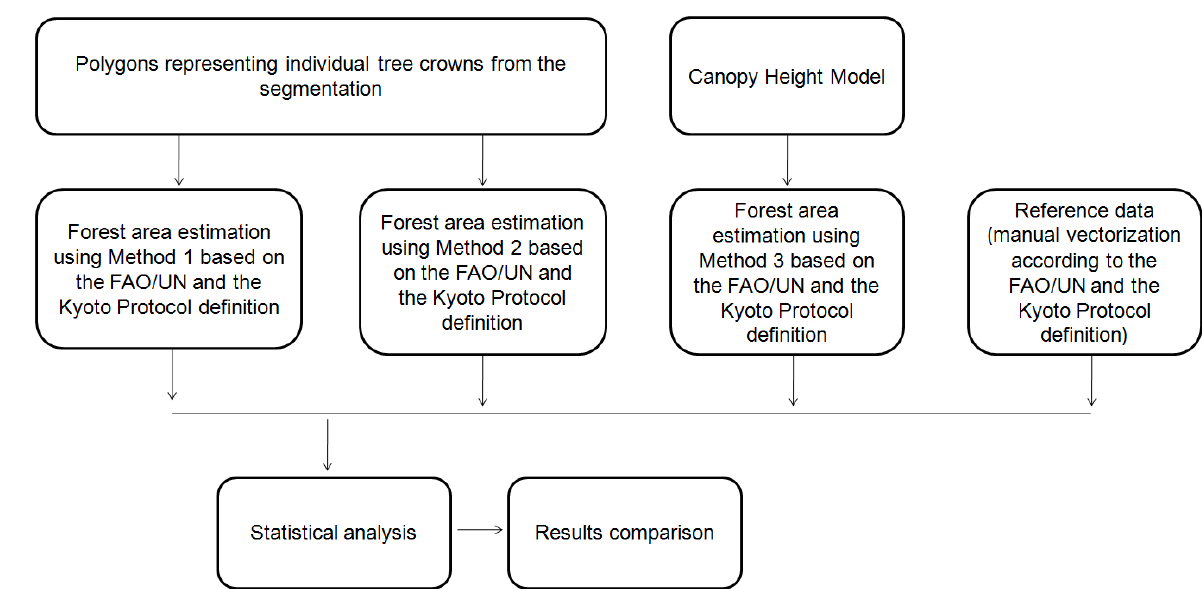
Figure 2. The scheme of the analysis.